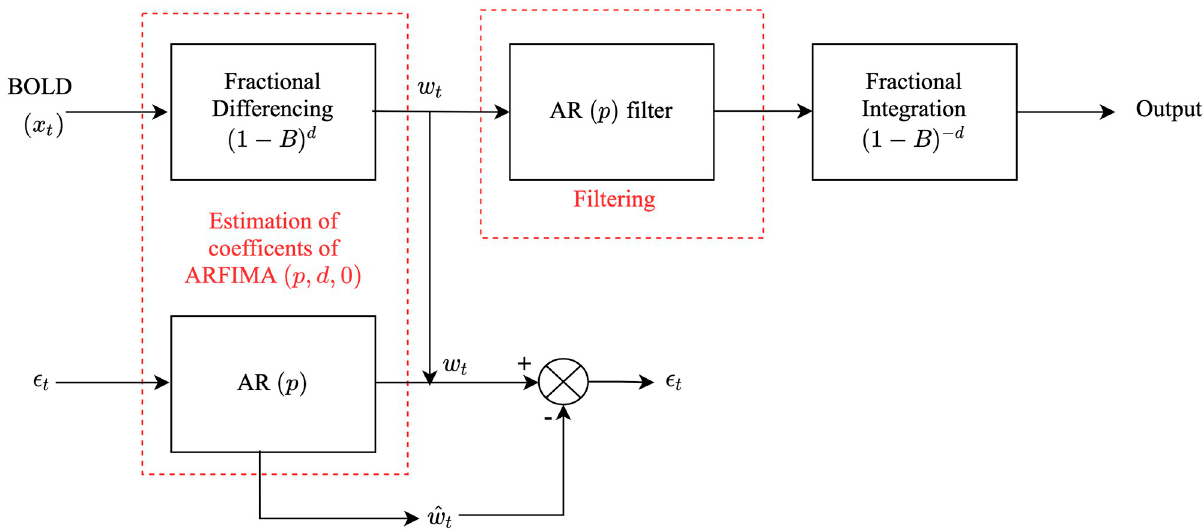
Fig 1. Block diagram of the proposed method to filter resting-state BOLD